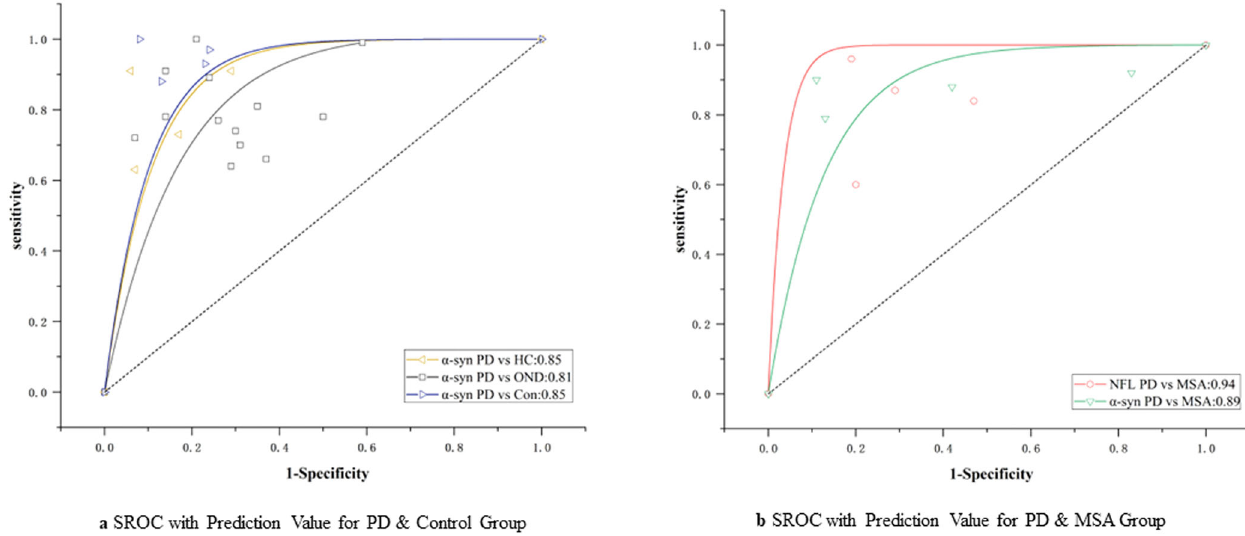
Fig. 4 SROC with prediction value for α -syn and NFL in two Groups. a SROC with prediction value for PD and control group; b SROC with prediction value for PD and MSA. SROC summary receiver operating characteristic curve, PD Parkinson ’ s disease, MSA multiple system atrophy, α -syn α -synuclein, NFL neuro fi lament light-chain